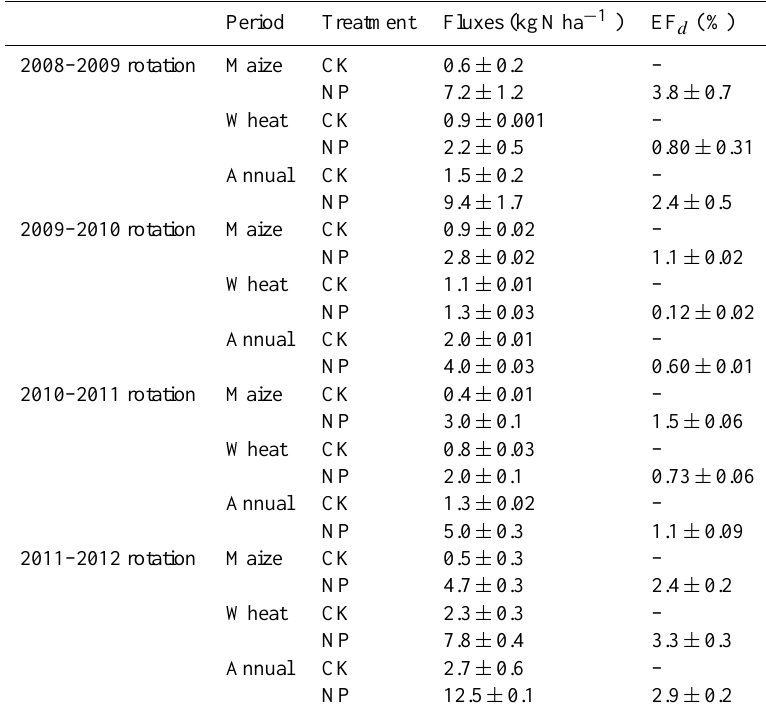
Table 3. Cumulative nitrous oxide (N 2 O) fluxes (mean ± SE) and direct emission factors (EF d ’s, mean ± SE) from different treatments of the investigated